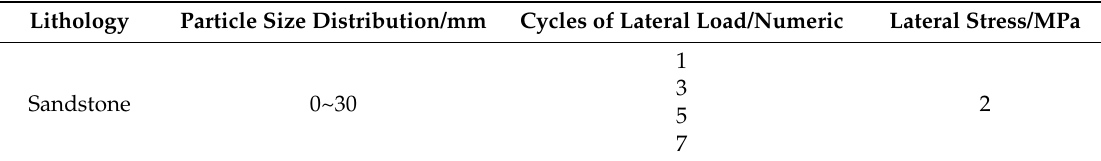
Table 1 . Detailed test scheme. Table 1. Detailed test scheme.